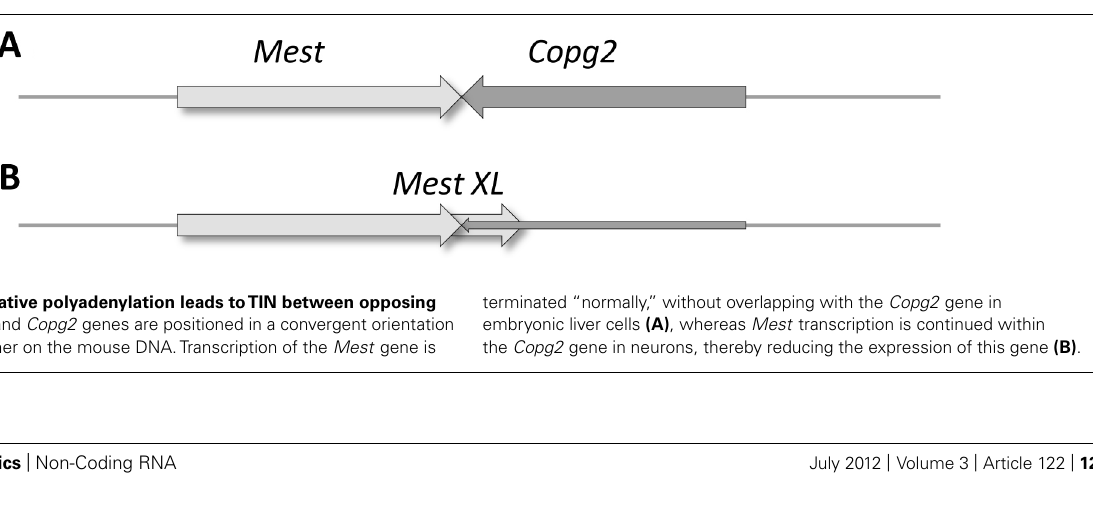
FIGURE 7 |Alternative polyadenylation leads toTIN between opposing genes. The Mest and Copg2 genes are positioned in a convergent orientation relative to each other on the mouse DNA.Transcription of the Mest gene is